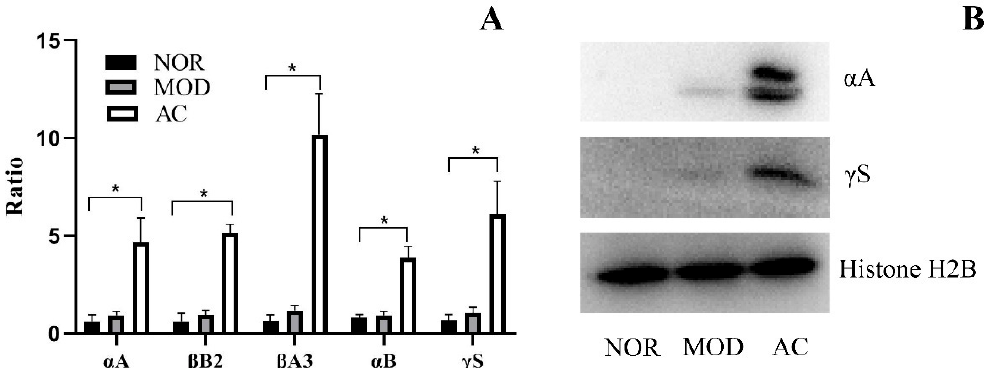
Figure 5. Expression of crystallin proteins in the rat retina. ( A ) Expression of α -crystallin A chain ( α A), β -crystallin B2 ( β B2), β -crystallin A3 ( β A3), α -crystallin B chain ( α B), and γ -crystallin S ( γ S) determined by mass spectrometry. The amount of each protein expressed in No.1 sample in NOR group (NOR-1) was set to be onefold, and the amount of crystallin proteins expressed in other samples were expressed as the ratio of NOR-1. Data shown are the mean ± standard deviations ( n = 3). (*) p < 0.05 (Kruskal–Wallis test followed by Dunn’s test). ( B ) Immunoblotting results showing the presence of α -crystallin A chain and γ -crystallin S in retina sample. The protein histone H2B in each sample was measured as an internal reference to show a basic protein expression in each